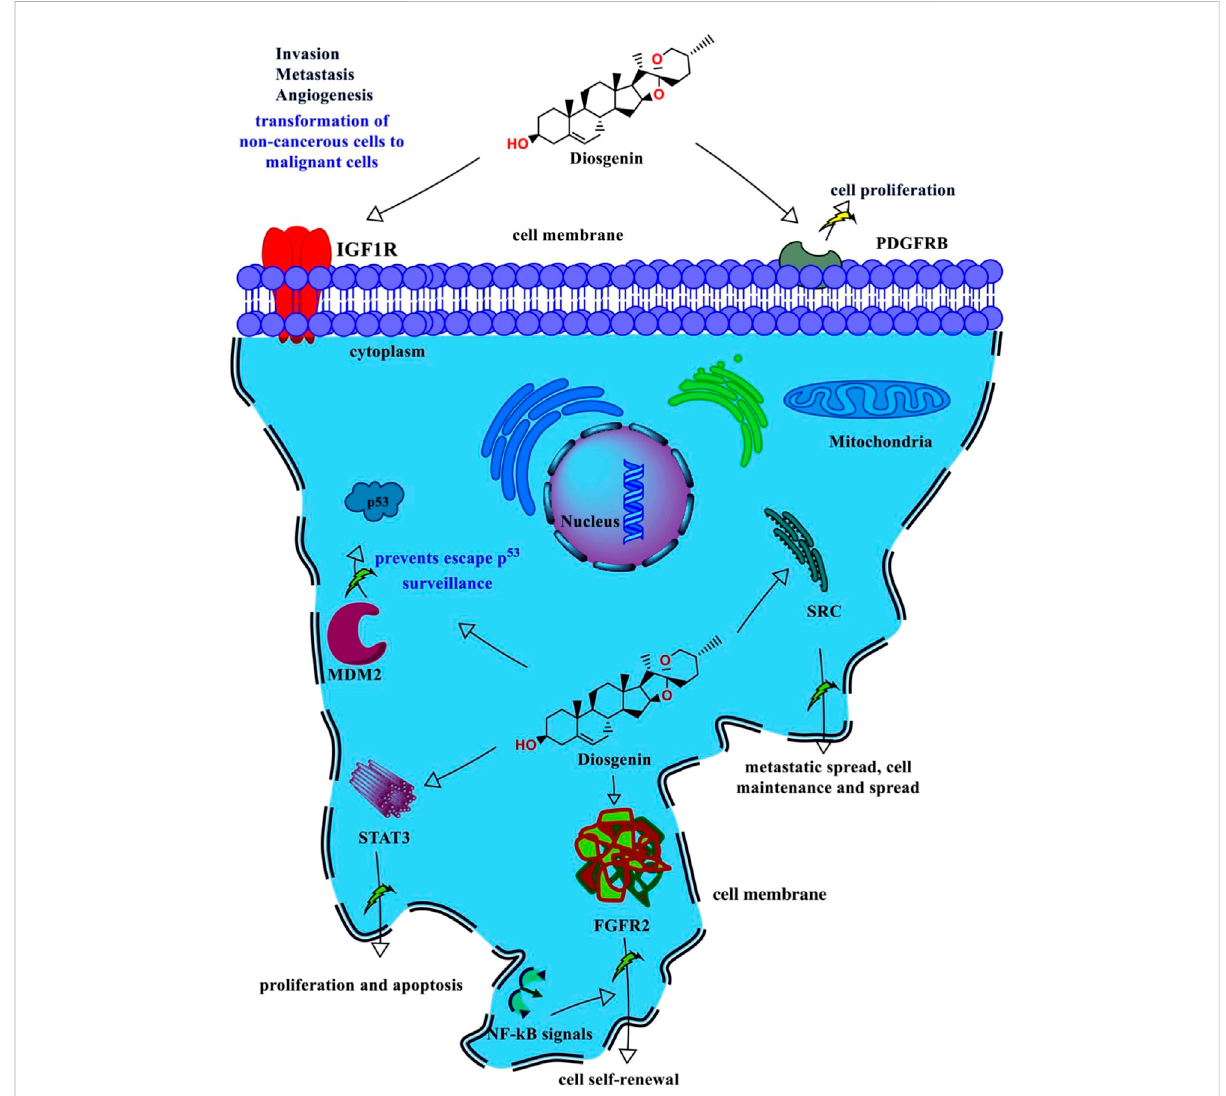
FIGURE 14 Mechanismofactionofdiosgeninagainstoestrogenreceptor-positivebreastcancer.Diosgeninactsonthetwocellsurfaceproteins IGF1R and PDGFRB and inhibits invasion, metastasis, angiogenesis, and cell proliferation. In addition, it acts on the four cytoplasmicproteins i.e., MDM2 , STAT3 , FGFR2, and SRC . Diosgeninmay inhibit thecell to escapep53 surveillance by binding with MDM2 ,inhibitcell proliferation and promote apoptosis by bindingto STAT3 ,interferewith NF-kB signals checkthecancercell